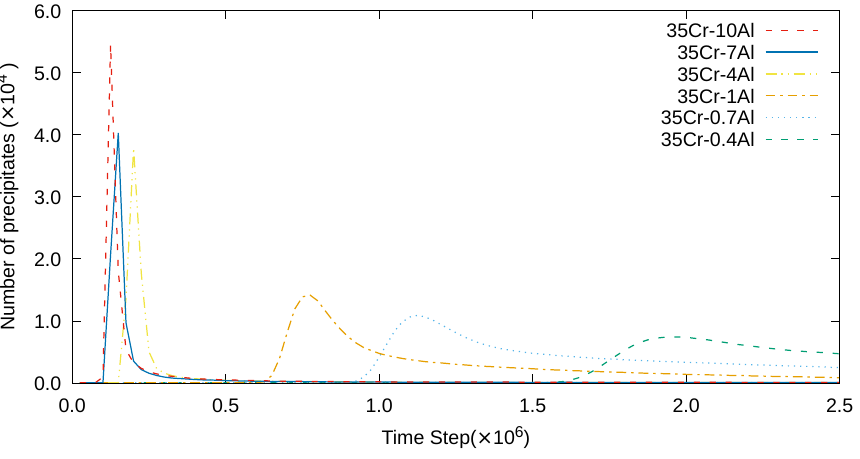
Figure 15. Number of α (cid:48) precipitates of the 3D simulation when the average Cr concentration was 35% at various average Al concentrations. Overshooting was observed before the t ∗ = 5.0 × 10 5 when the average Al concentration was above